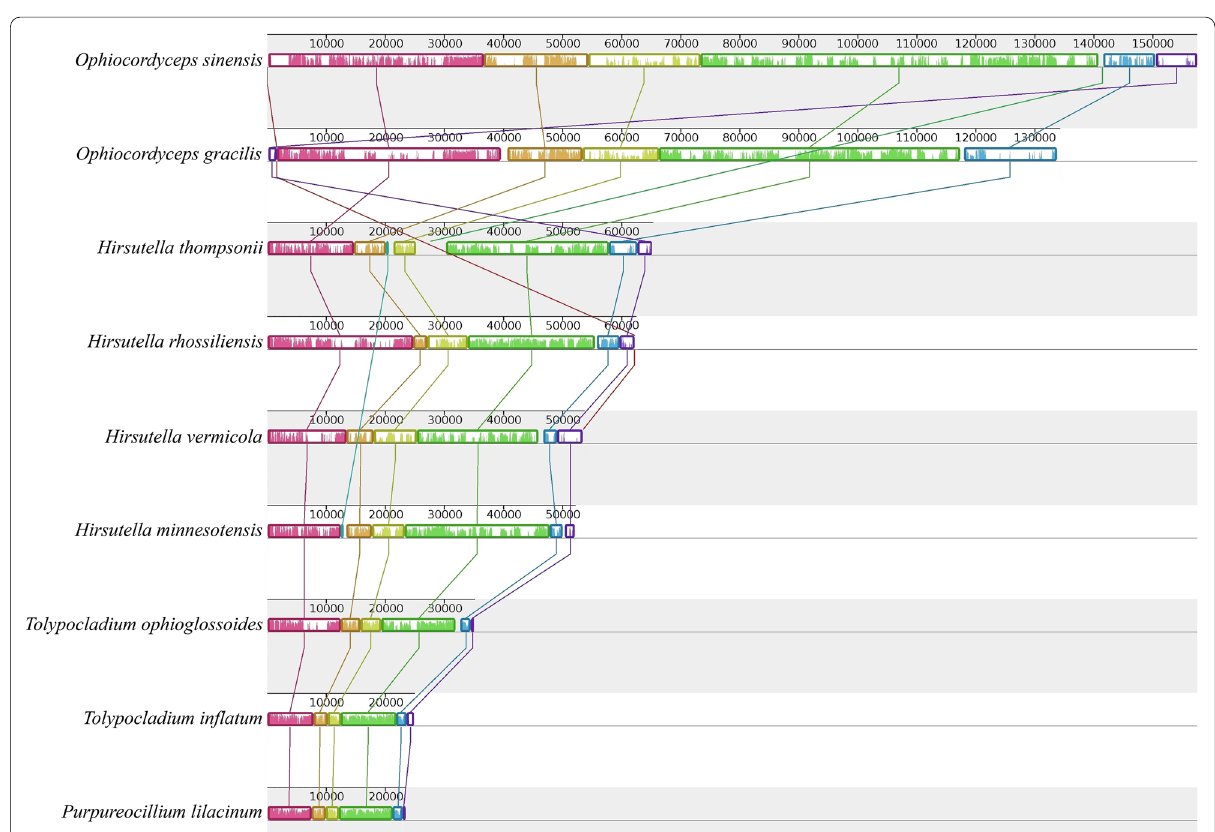
Fig. 3 Collinearity analysis of nine mitogenomes from Ophiocordycipitaceae. Homologous regions between different mitogenomes are represented by the same color blocks linked by